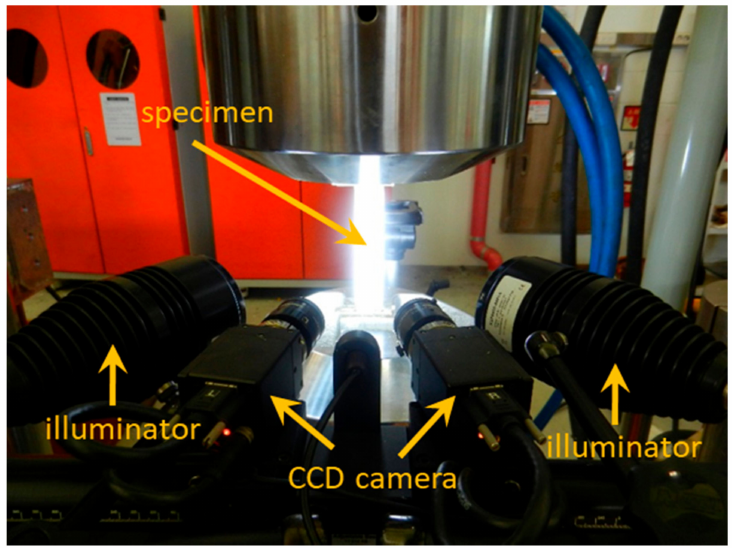
Figure 2. Experimental system configuration for digital image correlation (DIC)